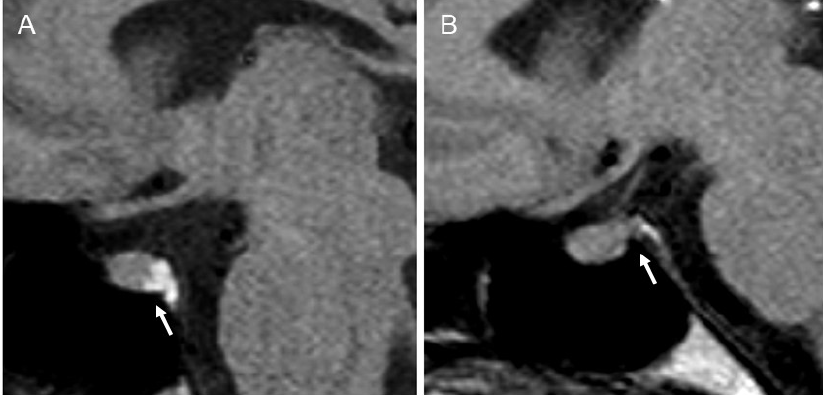
Figure 2. Pre-enhanced T1-weighted magnetic resonance imaging (MRI) scan of the pituitary gland. Arrows indicate ( A ) a normal hyperintense “bright signal” of the neurohypophysis in an unaffected control subject; ( B ) a reduced “bright signal” in the index patient.